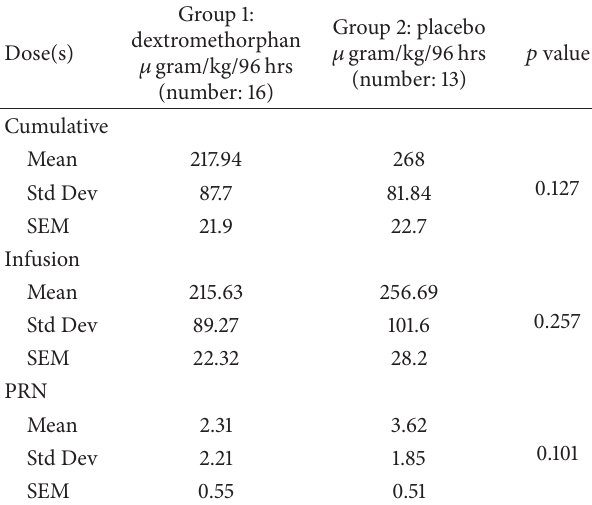
Table 3: Primary outcome in RCT. Comparison of dose(s) of fentanyl in groups. Groups compared via Student’s t -test for com- parison of means. 𝑝 < 0.05 is significant. Values are expressed as mean and standard